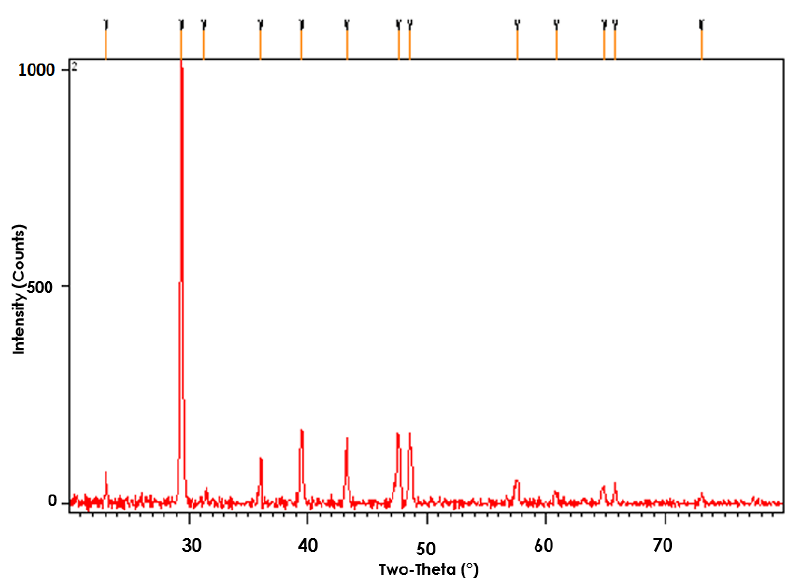
Figure 7. XRD Diffractogram of CUI-P1 EPS molecules.